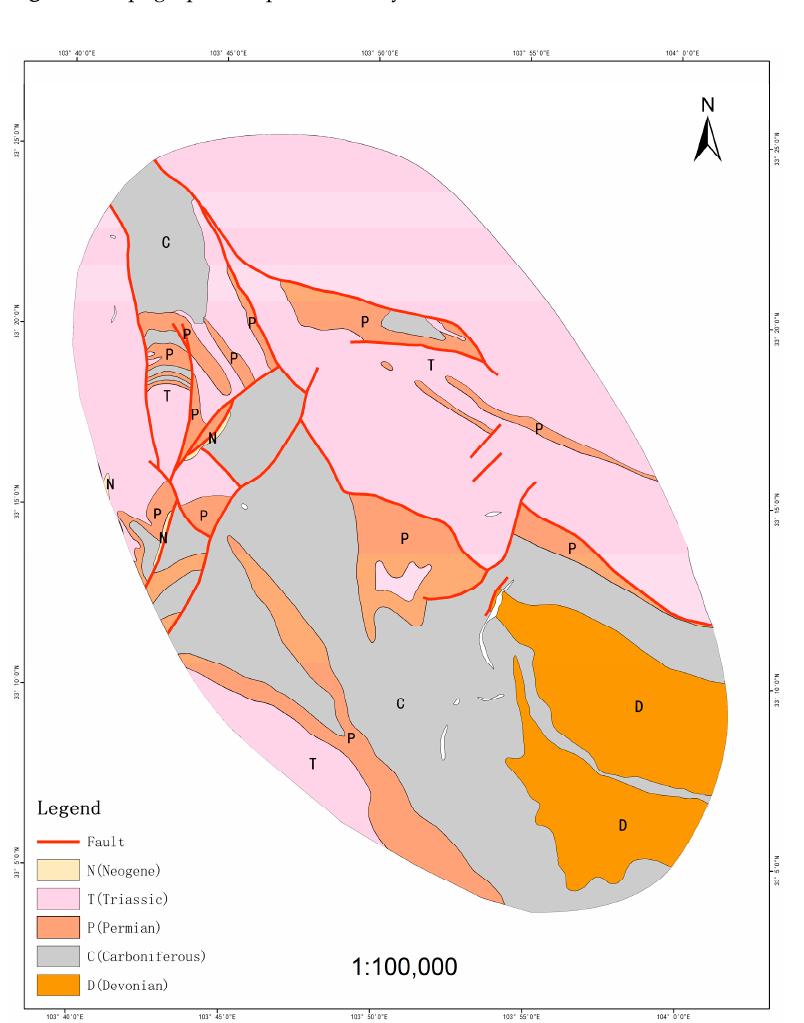
Figure 8. Basic geological map of the study area.